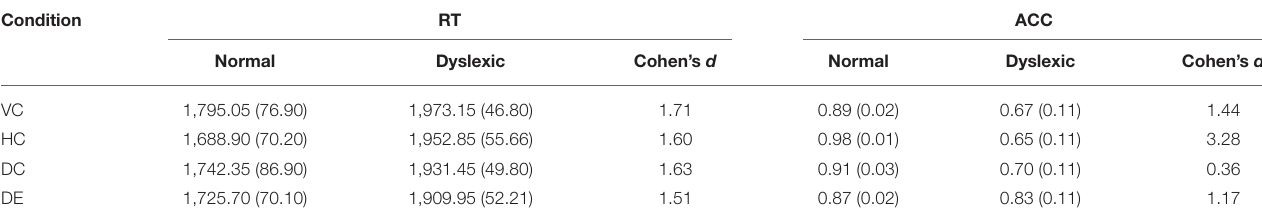
TABLE 1 | Mean and SD of both ACC and RTs in the four conditions.